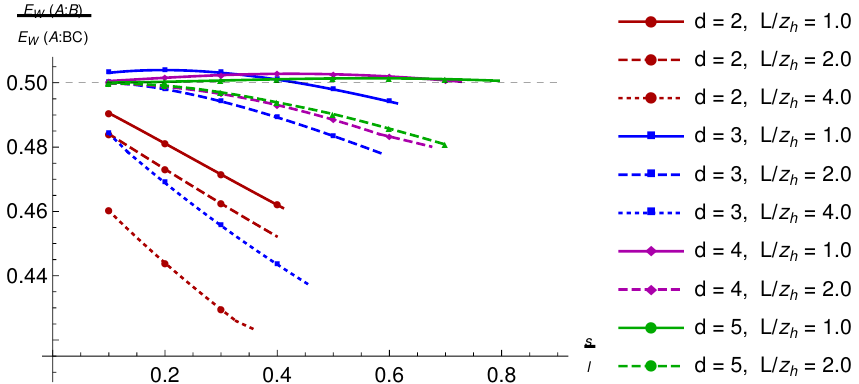
Figure 15 . The ratio of the wedges E W ( A : B ) /E W ( A : BC ) in the S B phase as a function of s/l for various d and total widths L in the ( d + 1) -dimensional AdS black brane background. nor polygamous. In particular, for large total width, i.e., L = 3 l + 2 s , the ratio E ( A : BC ) can be less than half even in the dominant S B ) /E W